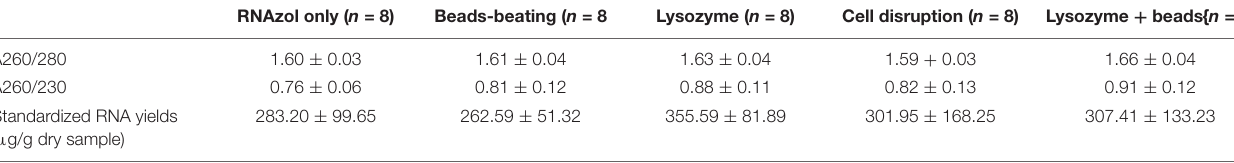
TABLE 1B | RNA purity (A260/280; A260/230) and standardized yields for organic isolation-based groups before additional purification step.